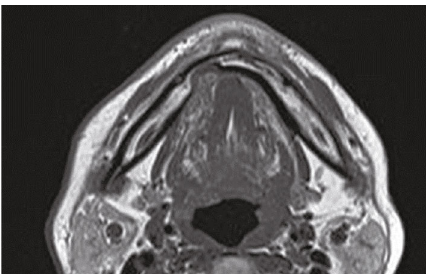
Figure 2: Computed tomography image, sagittal cross section, hard tissue mode. The lingual cortical bone recessed from the lingual to the buccal side is contiguous with the buccal cortical bone at the deepest point of the cavity. There is no connection of the apex of the adjacent #27 with the cavity in the lingual side of the mandible, and a high-density line suggests the presence of bony tissue between the apex of #27 and the cavity in the lingual side of the mandible.